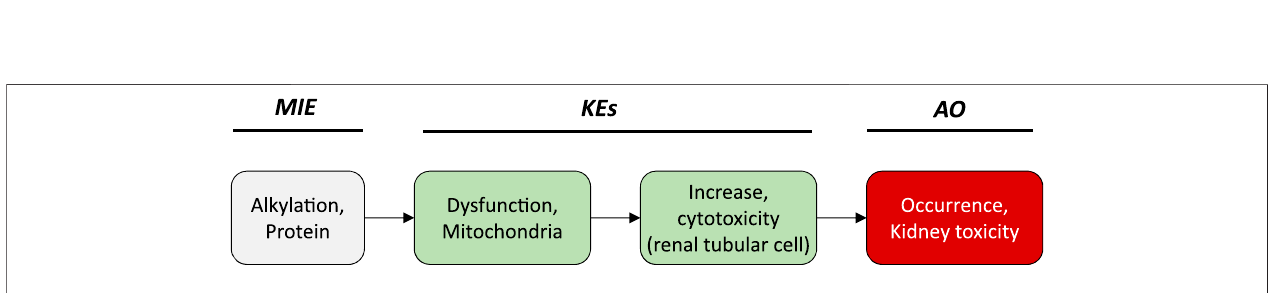
FIGURE 7 | Adverse outcome pathway of renal protein alkylation leading to kidney toxicity.